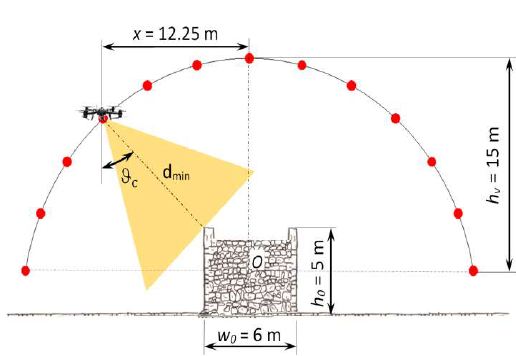
Figure 7. Gimbal rotation ϑ c in CG at ℎ (cid:3049) = 15 m.